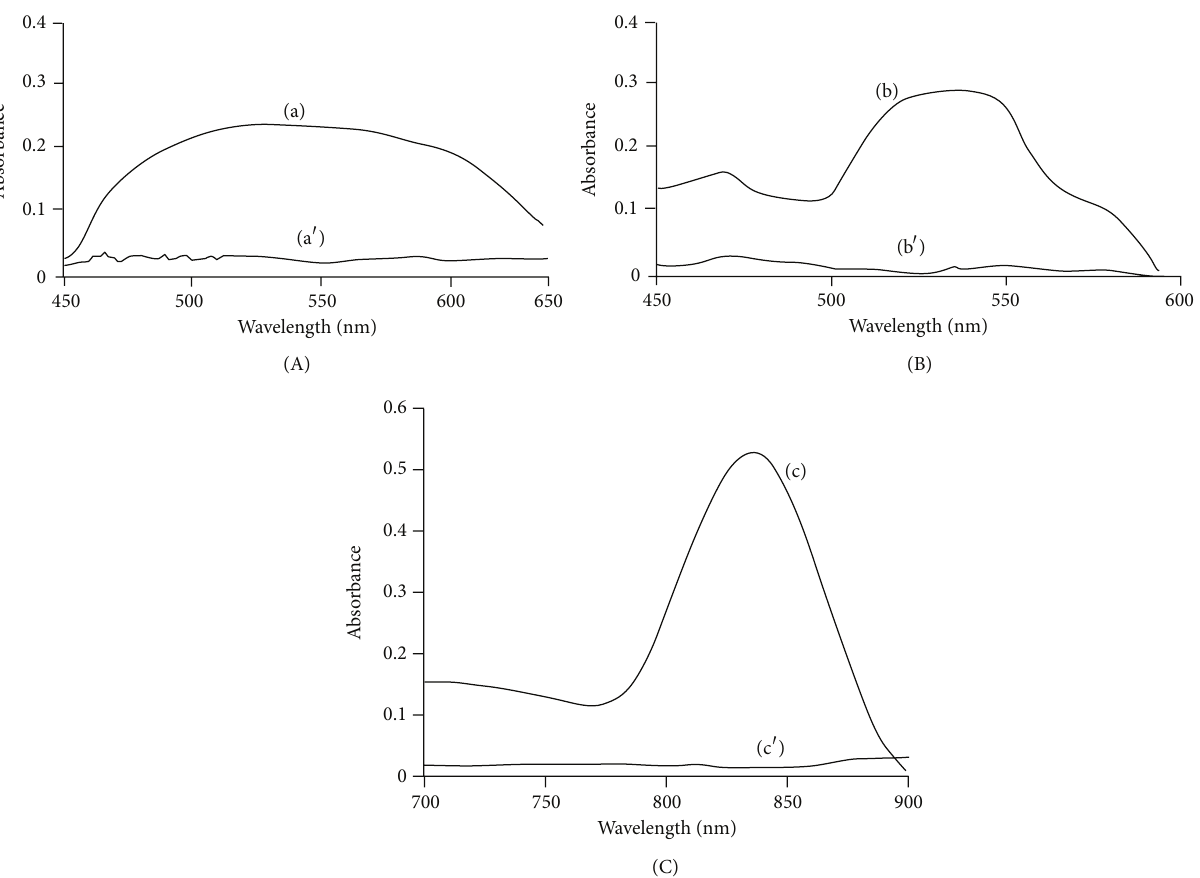
Figure1:(A):(a)Absorptionspectrumof35 𝜇 gmL −1 oftheproductoccurredinmethodAagainstreagentblankand(a 󸀠 )absorptionspectrum of the reagent blank of method A. (B): (b) Absorption spectrum of 30 𝜇 gmL −1 of the product occurred in method B against reagent blank and (b 󸀠 ) absorption spectrum of the reagent blank of method B. (C): (c) Absorption spectrum of 55 𝜇 g mL −1 of the product occurred in method C against reagent blank and (c 󸀠 ) absorption spectrum of the reagent blank of method